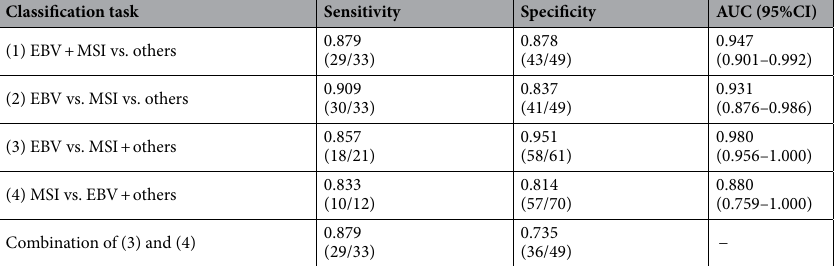
Table 3. Comparison of patient-level accuracy between classification tasks. The performance in detecting EBV + MSI/dMMR subgroup is shown for “EBV + MSI vs. others” and “EBV vs. MSI vs. others” tasks, whereas the values of “EBV vs. MSI + others” and “MSI vs. EBV + others” tasks are performances for detecting EBV and MSI/dMMR, respectively. “Combination of 3) and 4)” shows the performance for detecting EBV + MSI/ dMMR based on the results of 3) and 4) tasks. EBV, Epstein-Barr virus; MSI, Microsatellite instability; dMMR, Mismatch repair deficiency; AUC, Area under the curve; CI, Confidence interval.